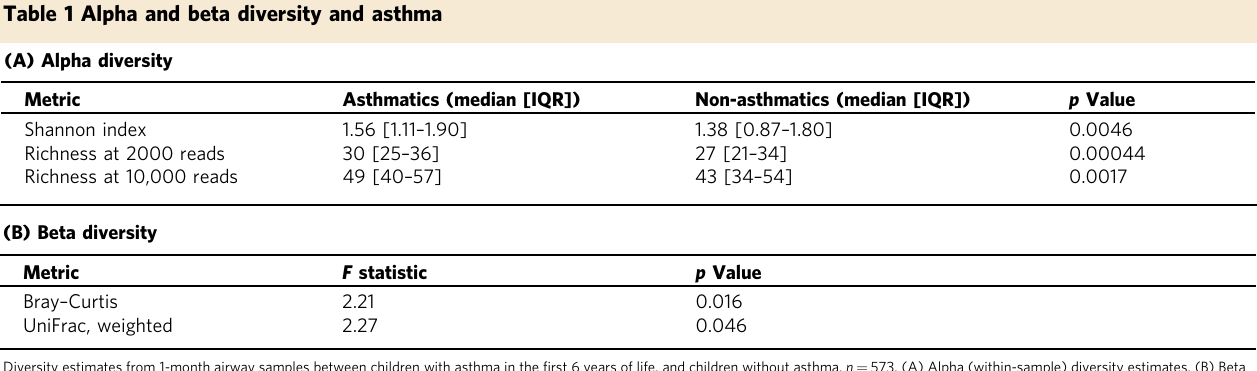
Table 1 Alpha and beta diversity and